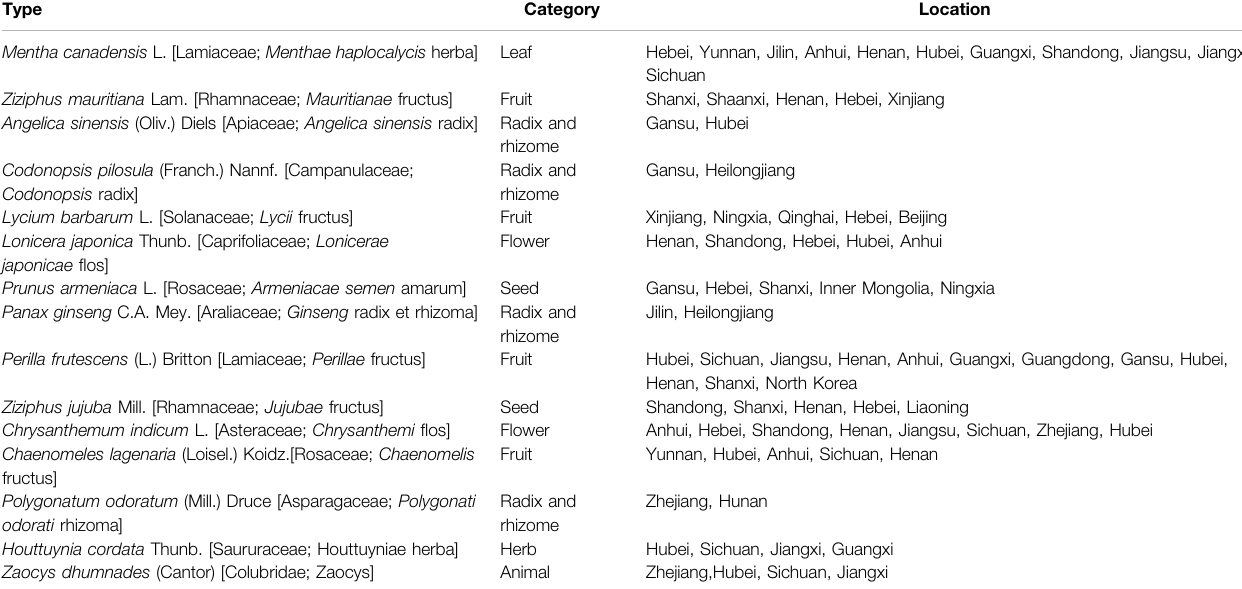
TABLE 1 | Sample collection information in this